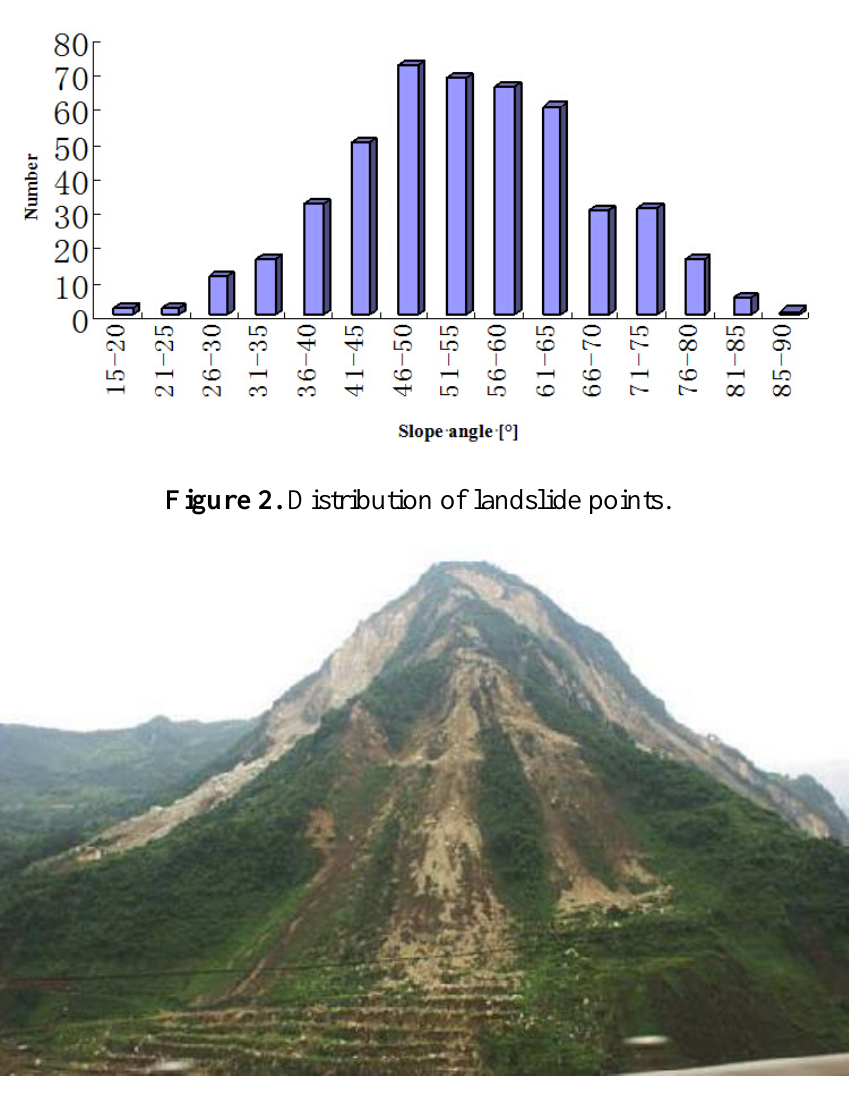
Figure 3. Damage phenomenon of a four sided rock slope in the Wenchuan